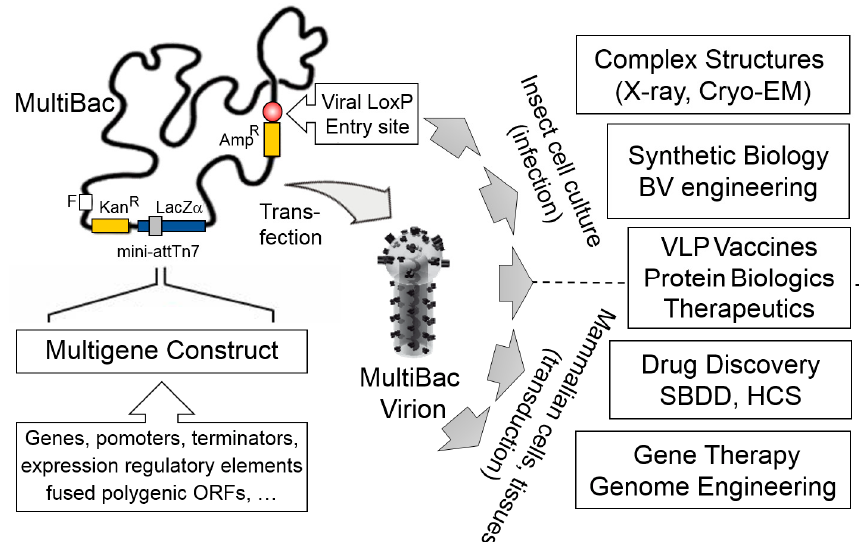
Figure 1. The MultiBac system. MultiBac consists of an engineered baculoviral genome optimized for multigene delivery and protein complex expression (left). The genome is present as a bacterial artificial chromosome (BAC) in E. coli cells supplying the Tn7 transposase. Expression cassettes comprising genes of interest and gene regulatory elements are assembled into the multi-gene expression constructs and inserted into the MultiBac genome by Tn7 transposition. The Tn7 attachment site is embedded in a LacZ α gene enabling blue-white screening of recombinants. A second entry option into the viral backbone is provided distal from the Tn7 site, relying on Cre recombinase catalysed site-specific integration into a LoxP sequence on the viral backbone (circle filled in red). This site can be used to customize MultiBac by providing additional functionalities. Composite MultiBac baculoviral DNA containing all DNA elements of choice is extracted from E.coli cultures, followed by transfection into insect cell cultures to manufacture functional MultiBac virions. These are then used for a wide range of applications (right), by the infection of insect cell cultures or transduction of mammalian cells, tissues and organisms. Cryo-EM, electron cryo-microscopy; X-ray, crystallography; BV, baculovirus; VLP, virus-like particle; SBDD, structure-based drug design; HCS, high-content screening. Amp, ampicillin; Kan, kanamycin; F, bacterial F replicon; LacZ α , gene encoding B-galactosidase α fragment; mini-attTn7, minimal Tn7 attachment site. Virion image is adapted from drawing kindly provided by Kari Airenne [28].